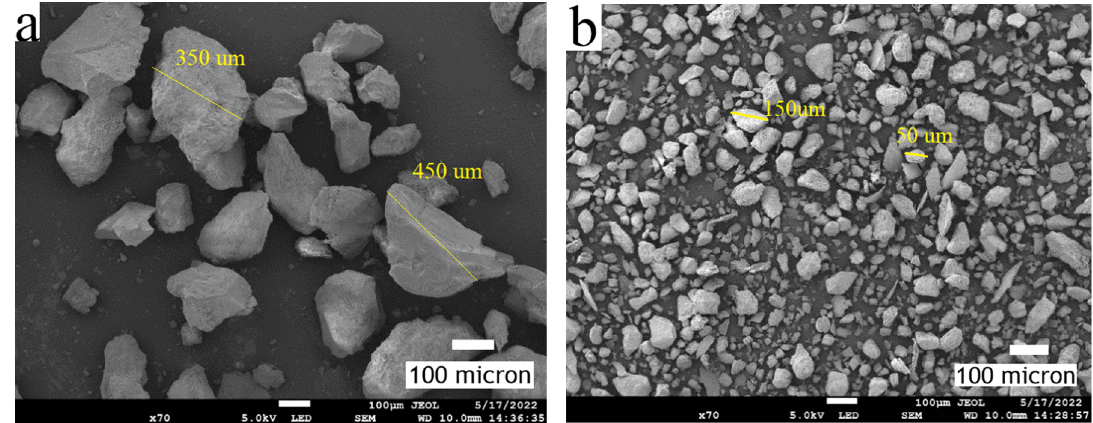
Figure 11. SEM micrographs of silica sand ( a ) before the test and ( b ) after the test.